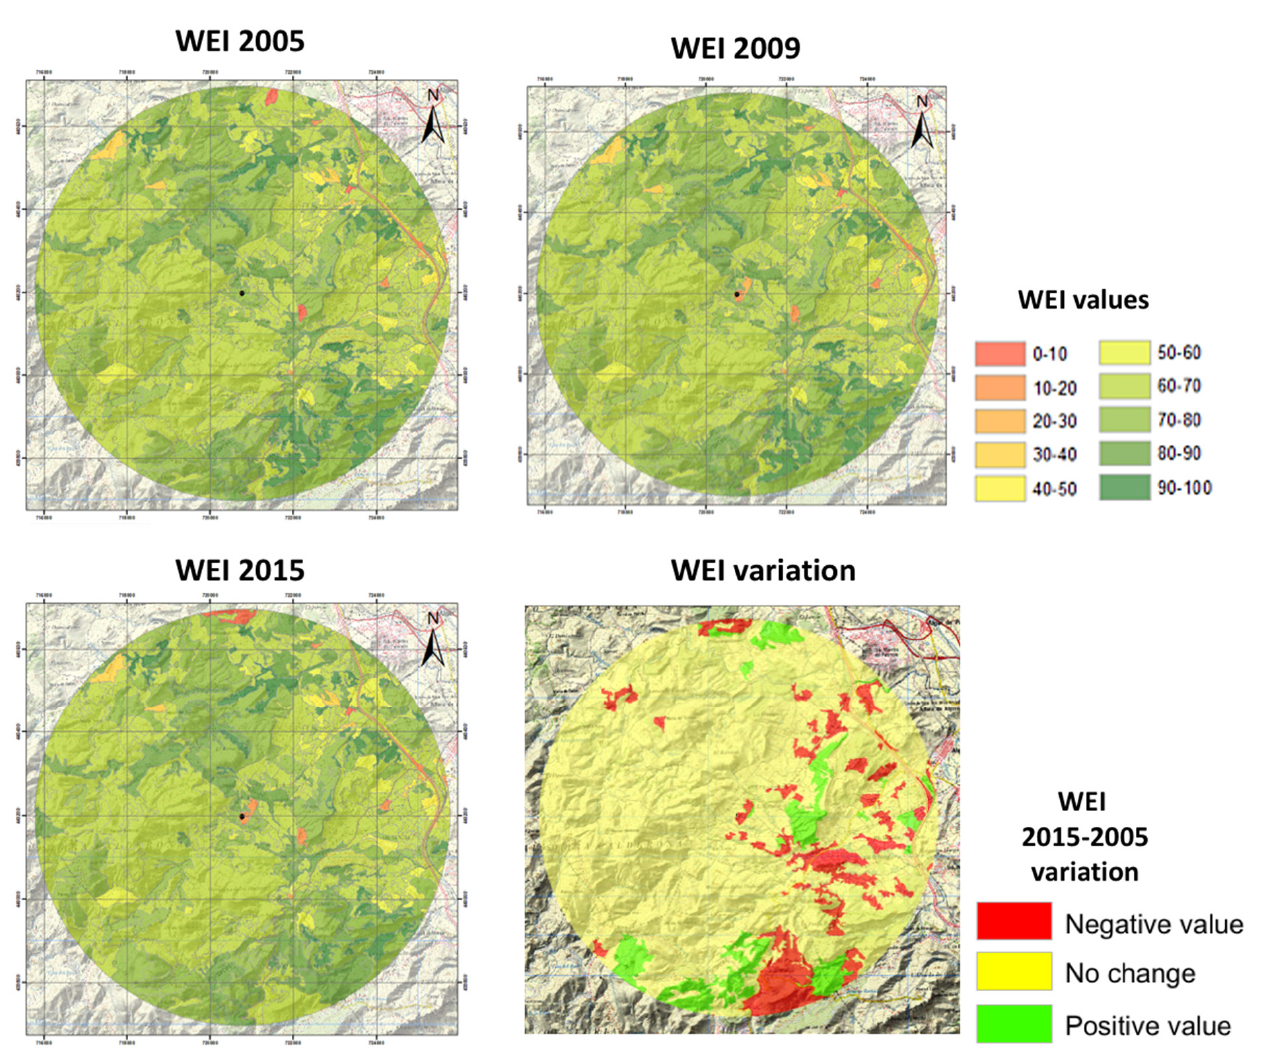
Figure 4. WEI distribution and variations in the Algimia de Alfara landfill between 2005 and 2015.